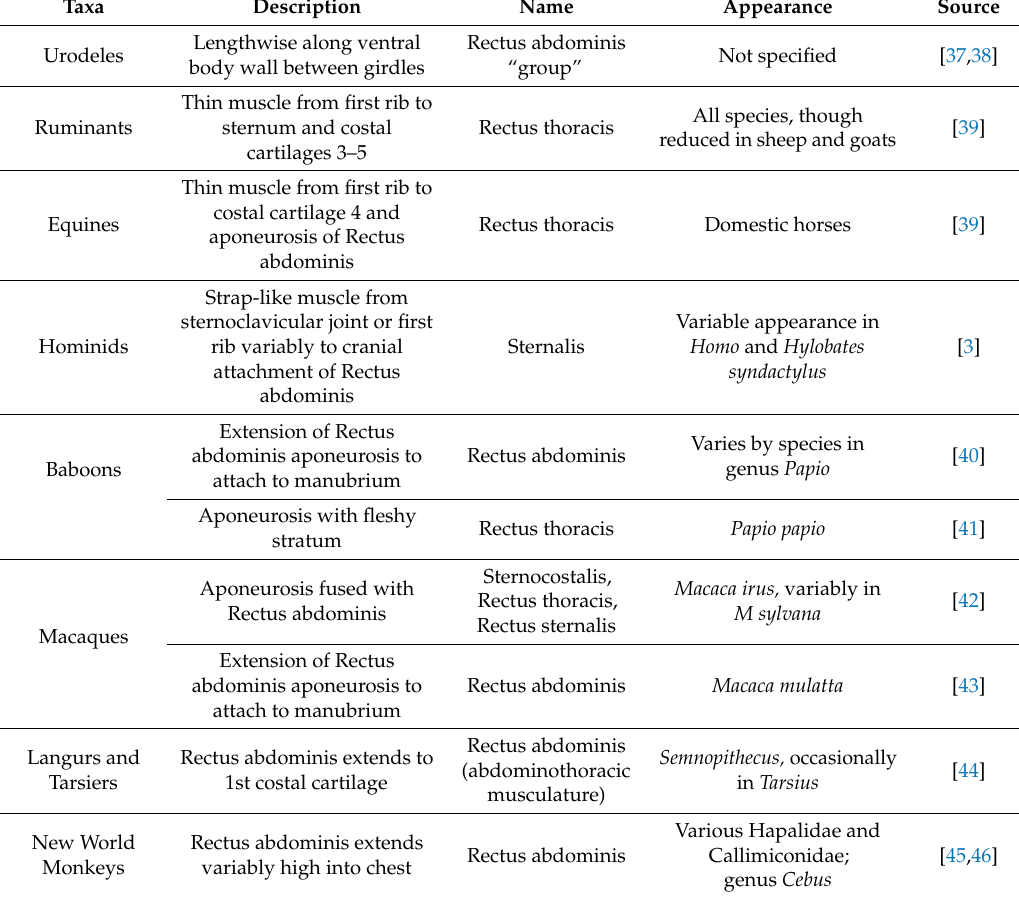
Table 3. Appearance of muscles similar to M sternalis in humans and other